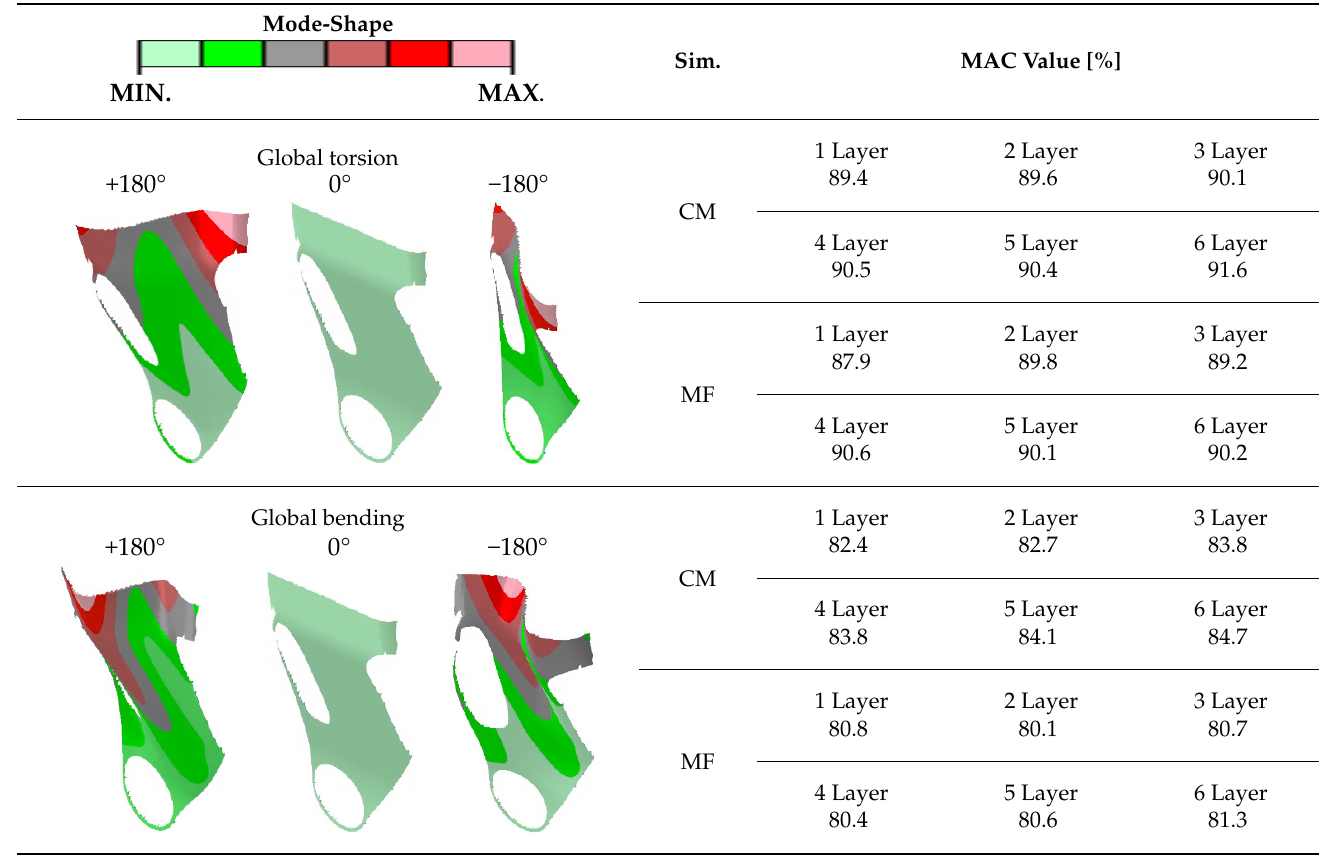
Table 8. Mode shapes of the structural dynamics simulation and MAC values in comparison to the experiment of the PA66GF50 engine bracket.